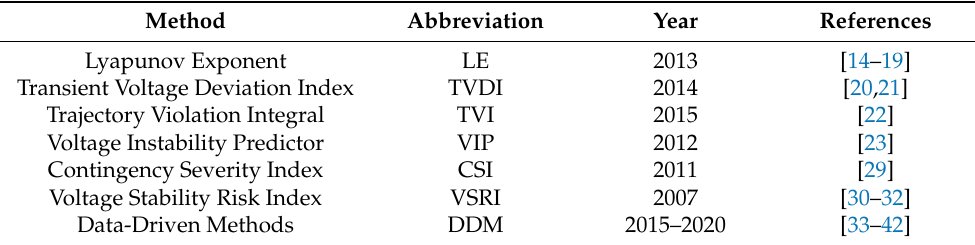
Table 1. Overview of the presented methods.